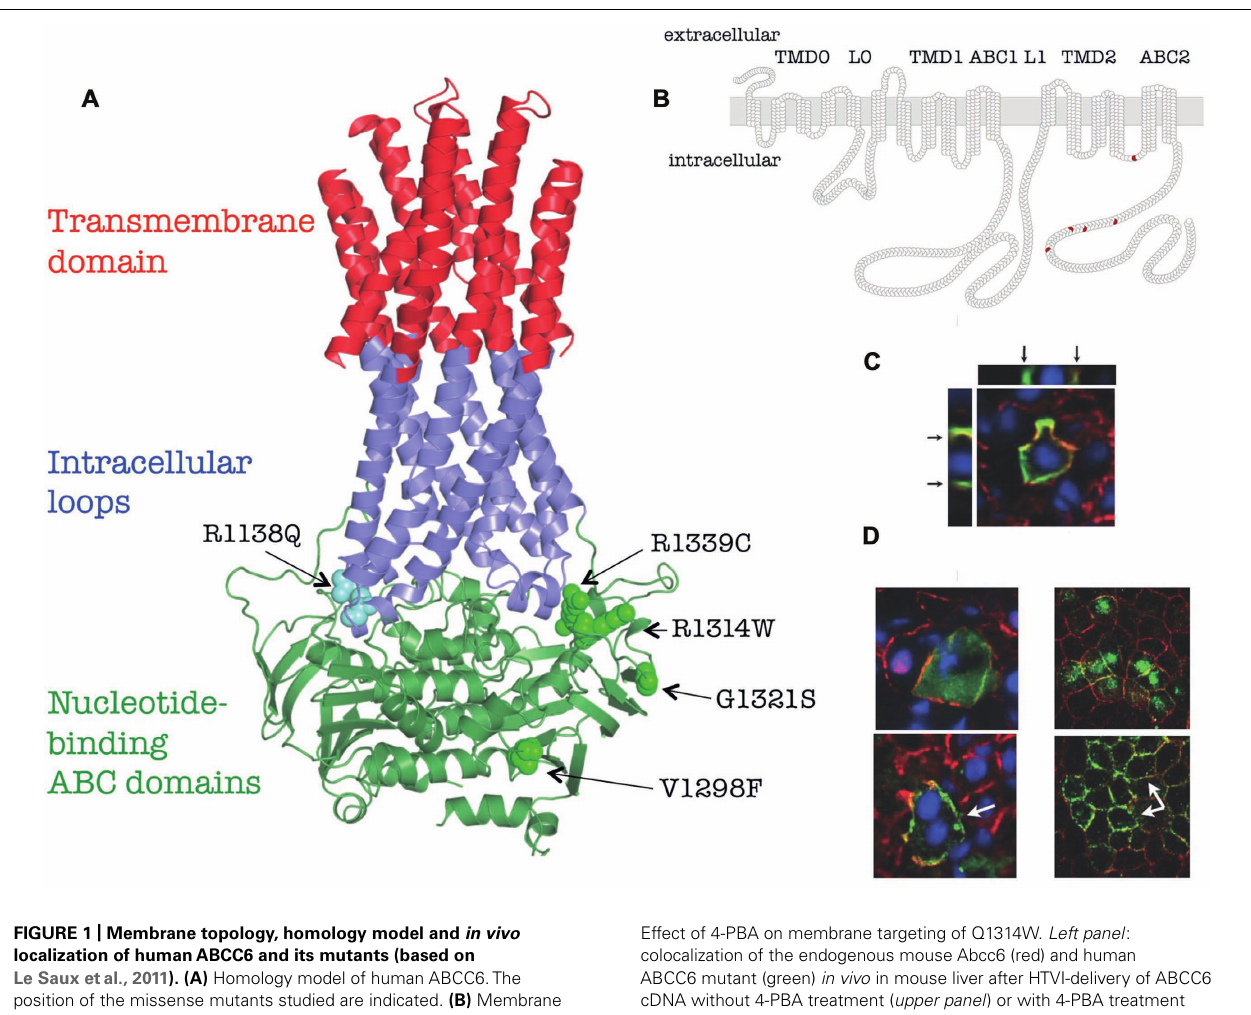
Effect of 4-PBA on membrane targeting of Q1314W. Left panel : colocalization of the endogenous mouse Abcc6 (red) and human ABCC6 mutant (green) in vivo in mouse liver after HTVI-delivery of ABCC6 cDNA without 4-PBA treatment ( upper panel ) or with 4-PBA treatment ( lower panel ). Right panel : colocalization of the endogenous dog Na/K-ATPase (red) and human ABCC6 mutant Q1314W (green) in vitro in polarized MDCKII cells without 4-PBA treatment ( upper panel ) or with 4-PBA treatment ( lower panel ).White arrows point to the altered membrane